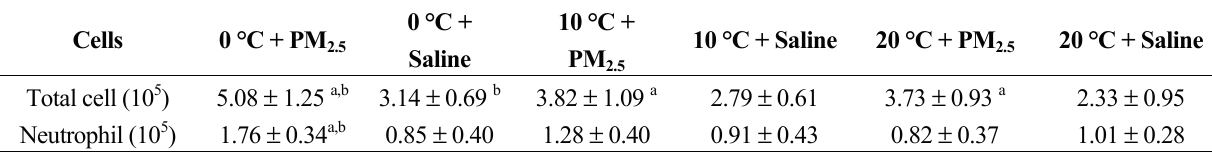
Table 1. The total cell numbers and neutrophils in bronchoalveolar lavage fluid (BALF) in all experimental